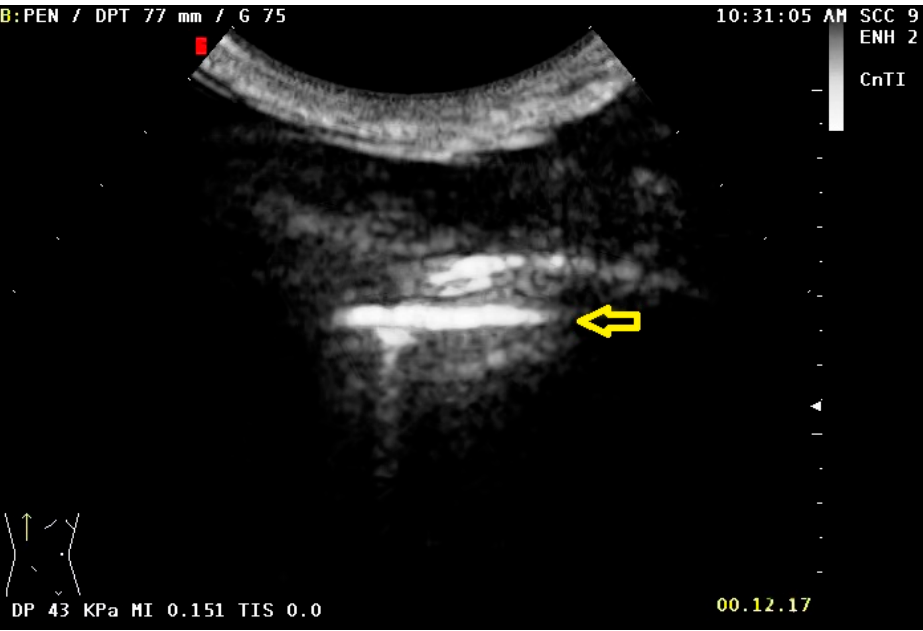
Figure 7. Duplication of the hyperechoic pleural line 10 s after administration of the US contrast agent (yellow arrow).